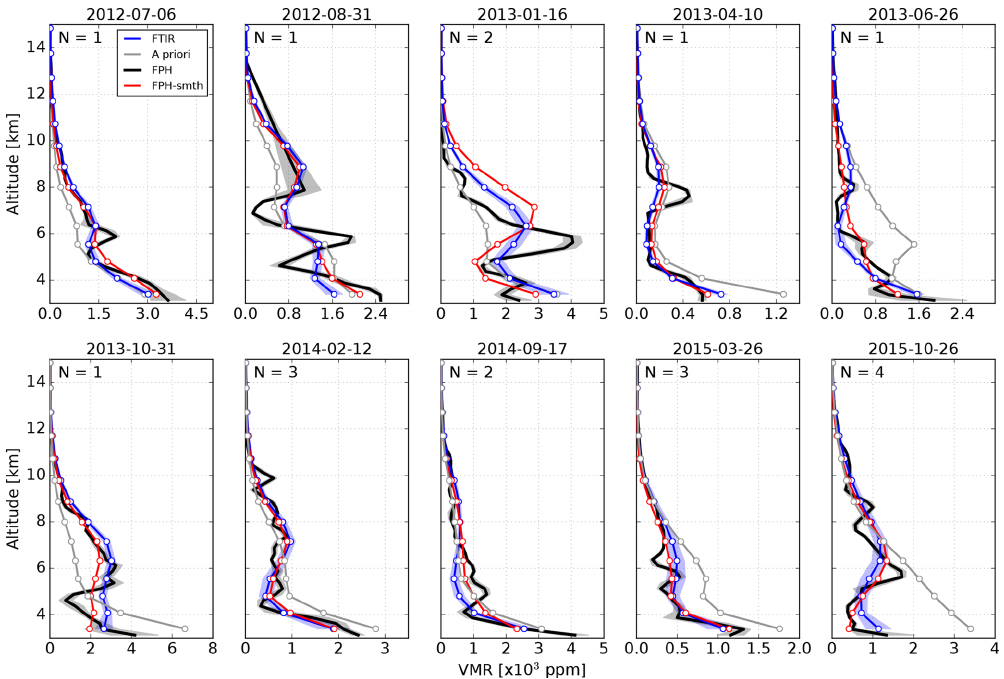
Figure 5. Same as Fig. 4 but for